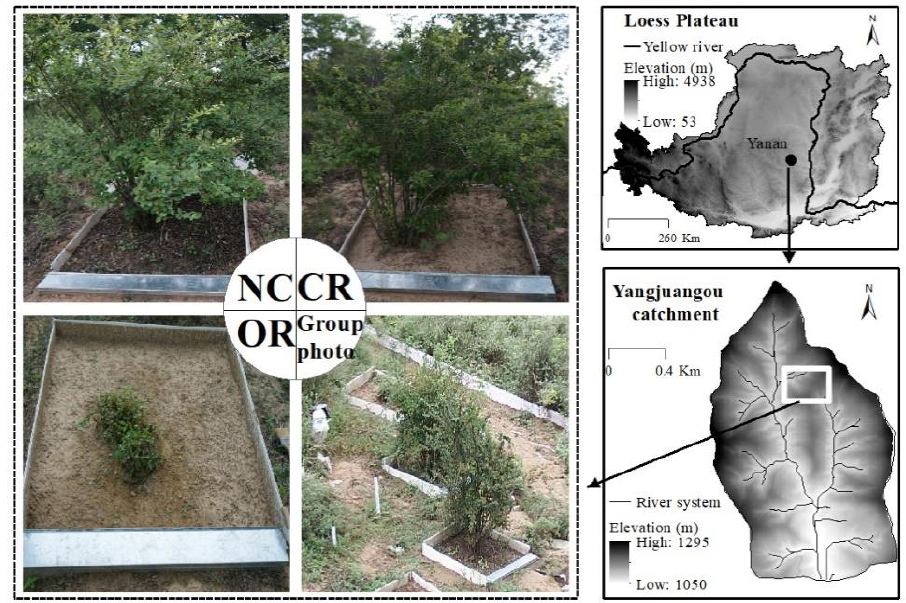
Figure 1. Location of the study area and the plots with different treatments. NC shows the natural condition including the canopy, litter, and roots of plants. CR indicates the state of the canopy + roots after removing the litter. OR represents only the roots after removing both the canopy and litter.